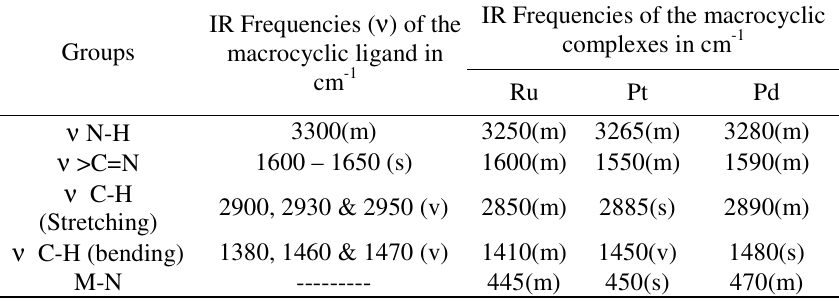
Table 2. IR spectral data of given tetraaza macrocyclic ligand (L) and its complexes.